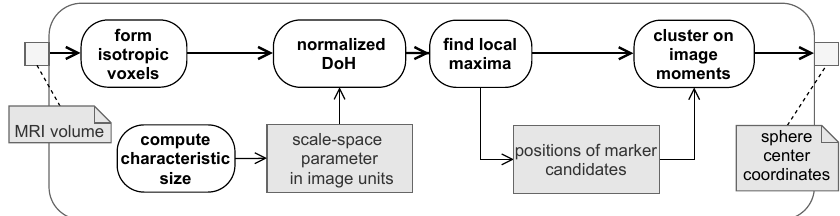
Figure 7. Pipeline for the blob-detection related